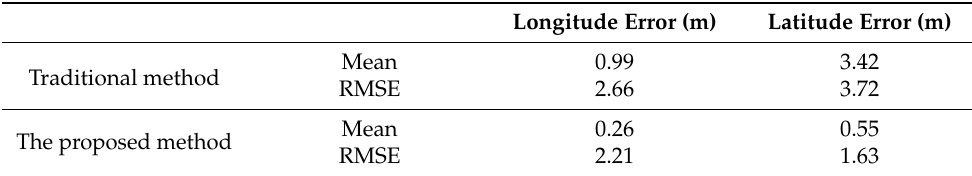
(c) Horizontal position error Figure 7. Comparison result of position error in the kinematic test. Table 3. Mean and RMSE of position error under vehicle stationary condition. Longitude Error (m)